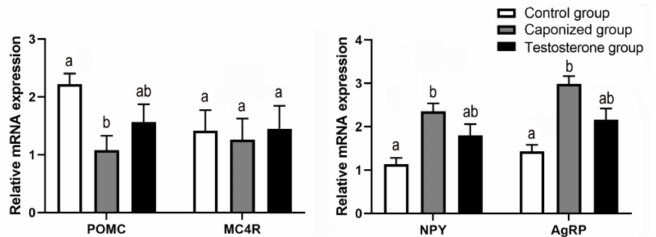
Figure 3. Genes’ mRNA levels relative to β -actin , POMC , MC4R , NPY , and AgRP of hypothalamus in the control, the caponized group, and the testosterone group. Data are shown as mean values ± standard error of the mean. Vertical bars represent the standard errors of the mean. Different letters above the bars denote significant differences ( p <